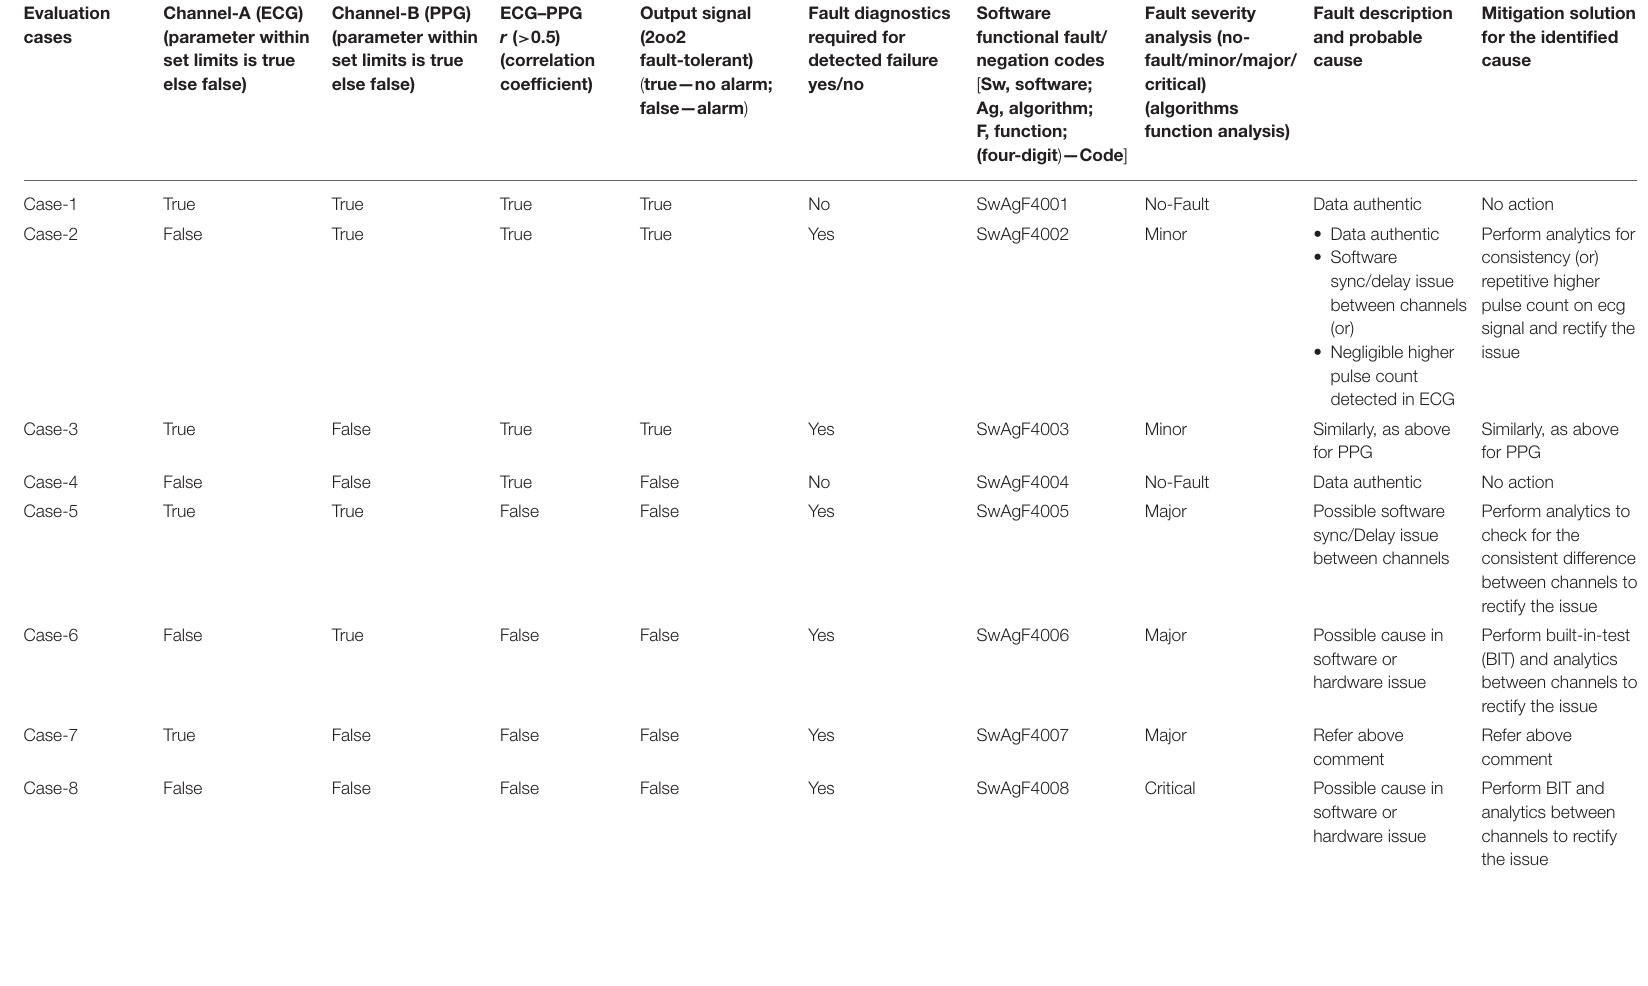
TABLE 3 | 2oo2-based cause and effect—fault detection and evaluation analysis and feasible mitigation solution for the identified cause. Evaluation